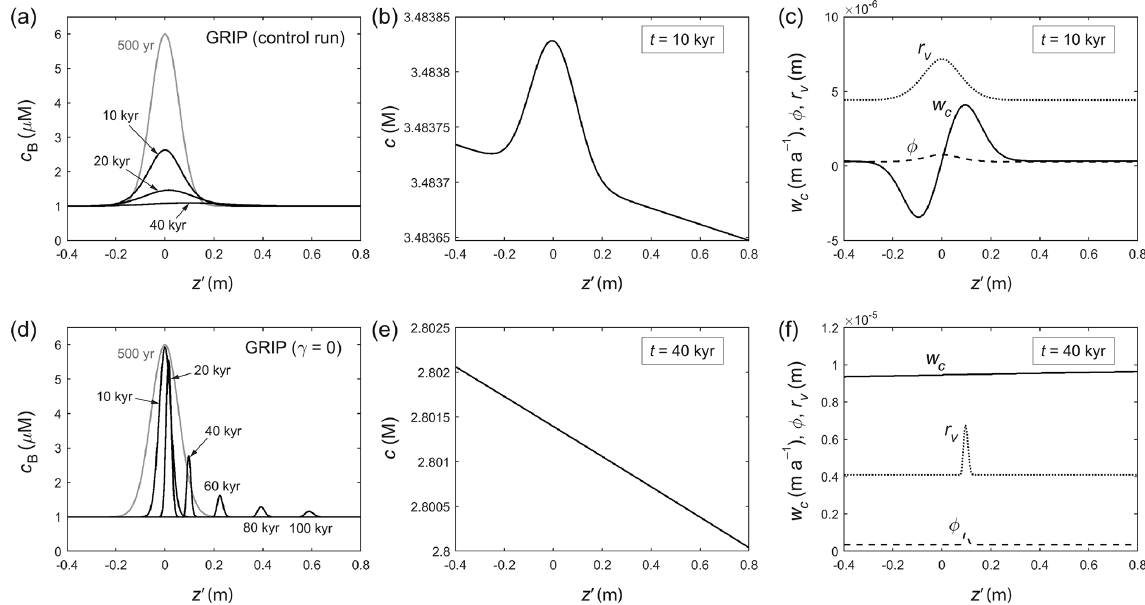
Figure 5. Modelled evolution of a signal peak in (a) – (c) the GRIP control run and (d) – (f) an otherwise identical run where the Gibbs– Thomson effect is turned off ( γ = 0). Snapshots are shown in the material reference frame, with displacement z (cid:48) measuring how far the signal has moved from ice of the same age (which lies at z (cid:48) = 0). (a, d) Bulk solute concentration c B ; (b, e) vein solute concentration c at one time; (c, f) anomalous velocity w c , porosity φ , and vein curvature r v at one time. Grey curves in (a) and (d) indicate the initial doped peak. Panel (b) illustrates the Gibbs–Thomson perturbation. See Movie S1 for the full